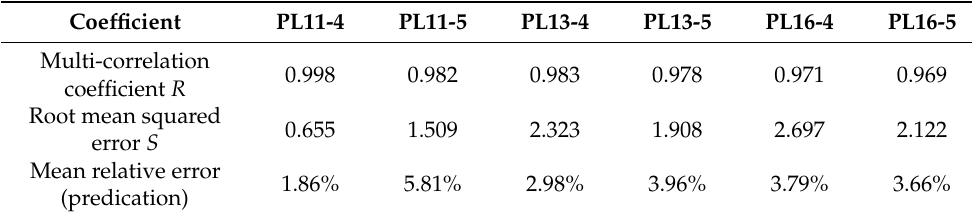
Table 5. Model accuracy of representative key monitoring